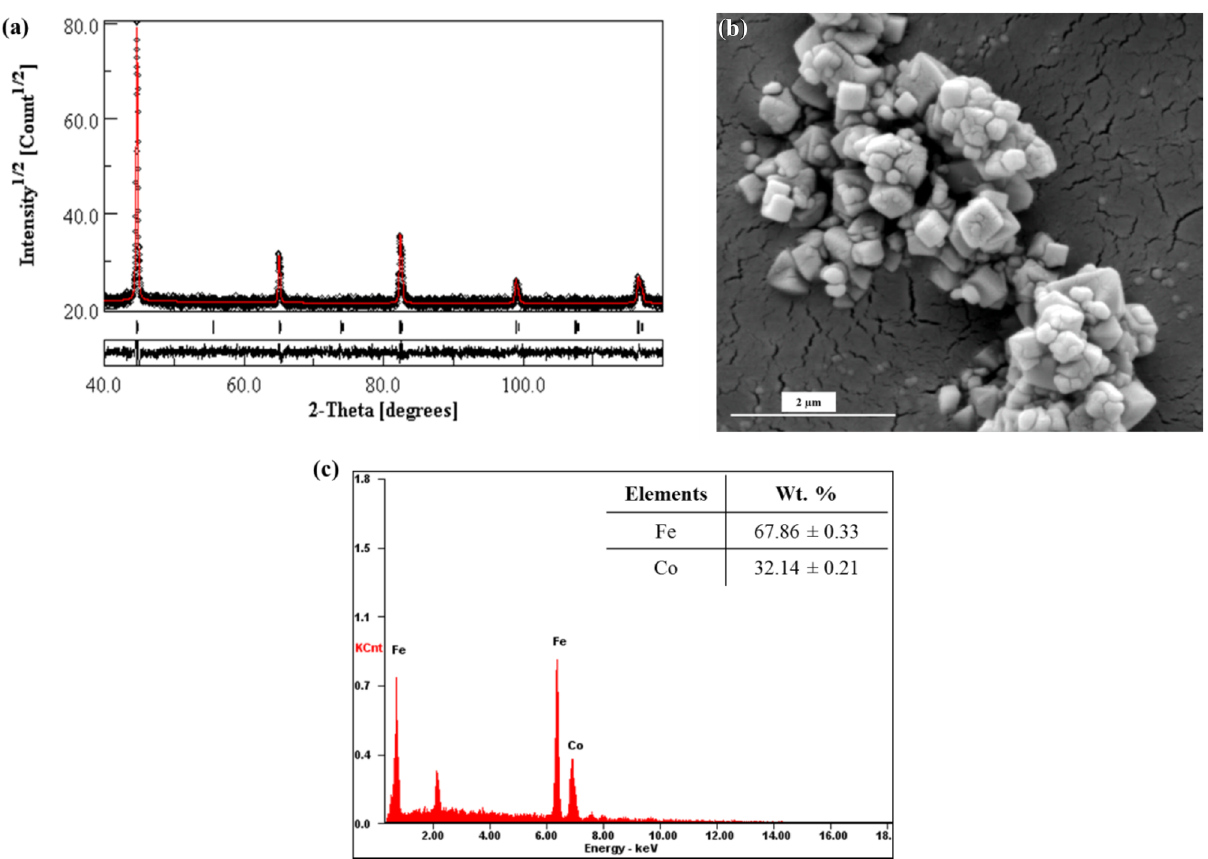
Figure 2. ( a ) XRD pattern of the Fe–Co alloy synthesized in the present work (peak profile fitting carried out using MAUD); ( b ) SEM micrograph of the Fe–Co particles and ( c ) composition of the particles as acquired by